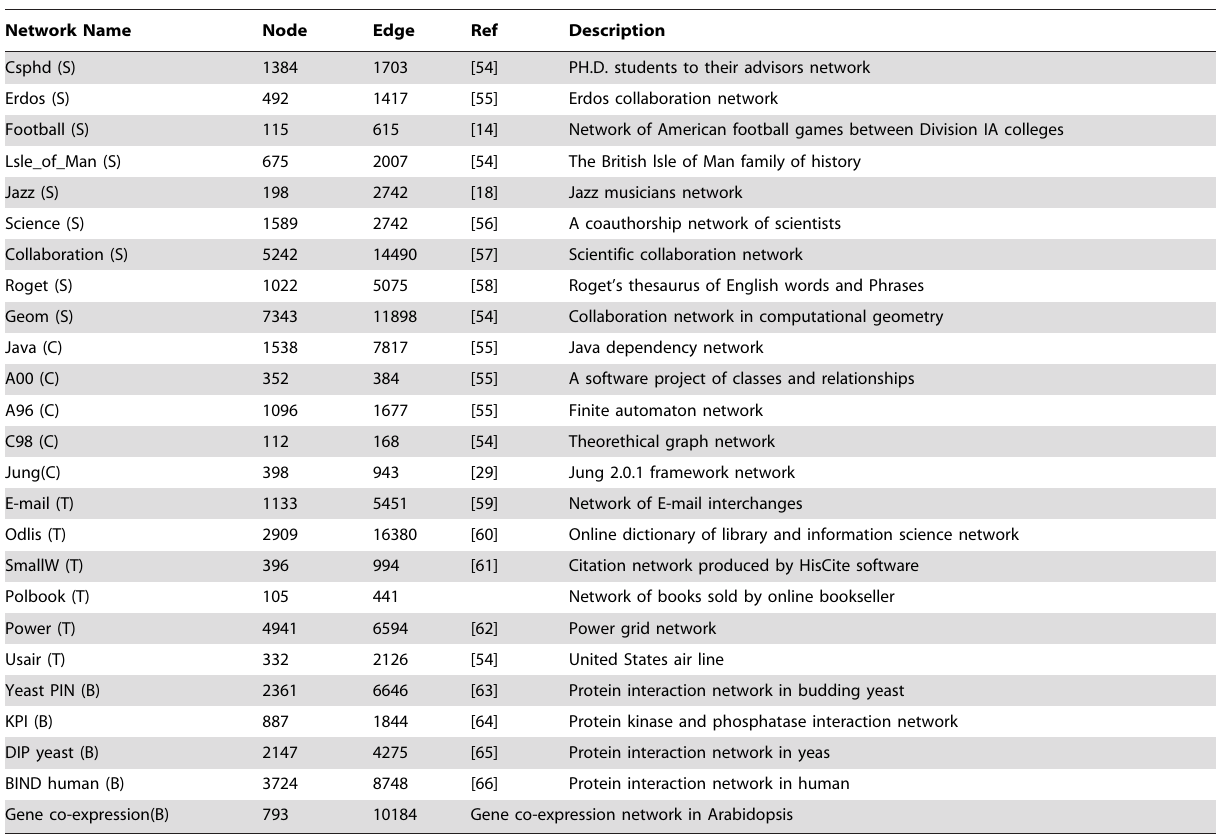
Table 3. Descriptions of 25 networks studied in this